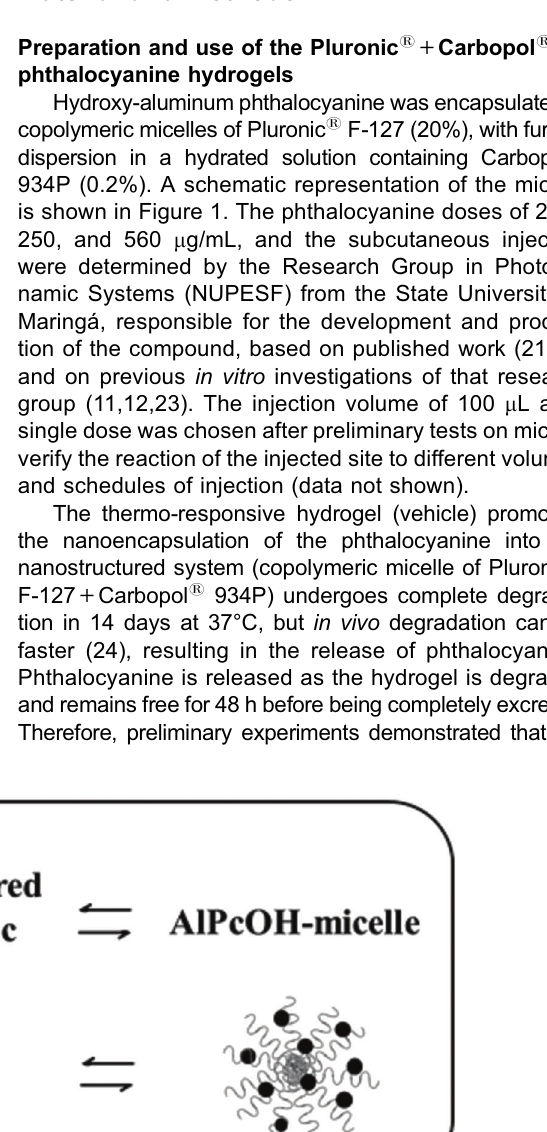
Braz J Med Biol Res | doi: